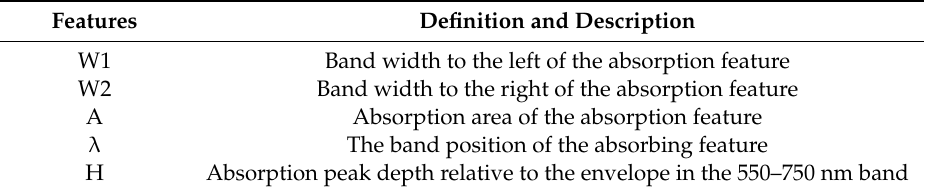
Table 3. Spectral absorption features based on continuum